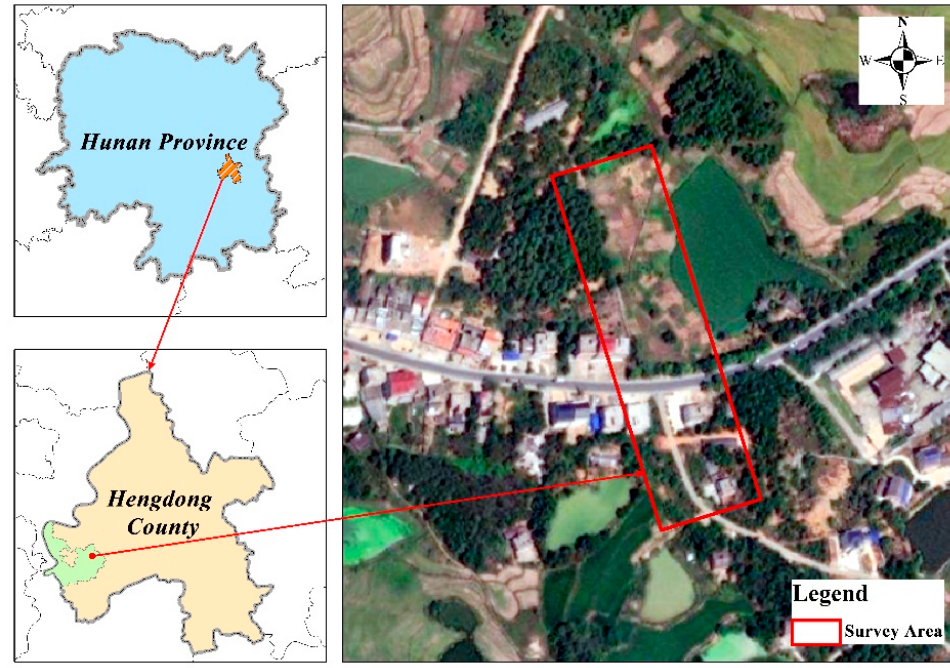
Figure 1. Overview of survey area.